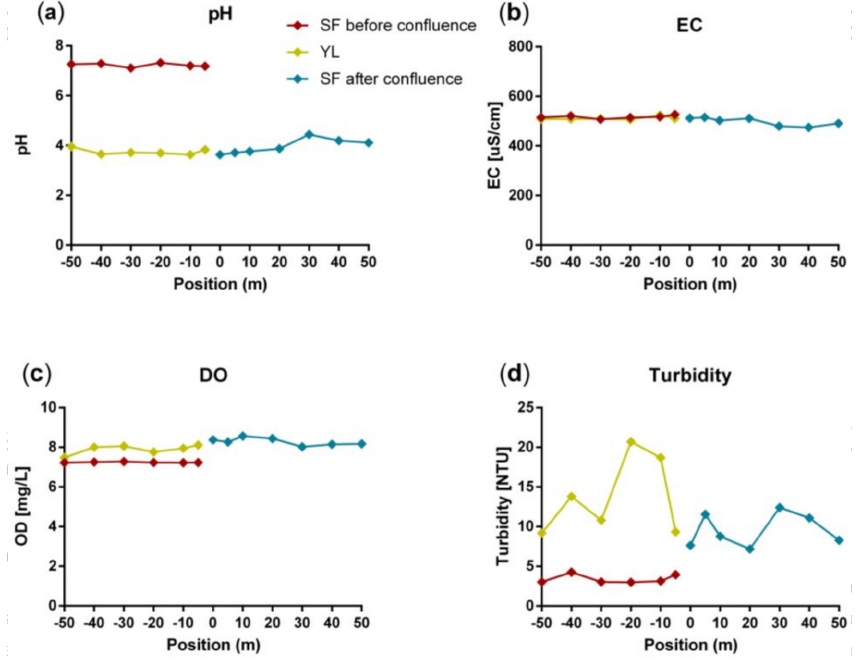
Figure 2. Water parameters of the study site: ( a ) pH; ( b ) Electric conductivity; and ( c ) Dissolved oxygen correspond to on-site measurements; while ( d ) Turbidity was measured in the laboratory. Symbology is related to the San Francisco River (SF) before the confluence and after the confluence, and the Yerba Loca Creek